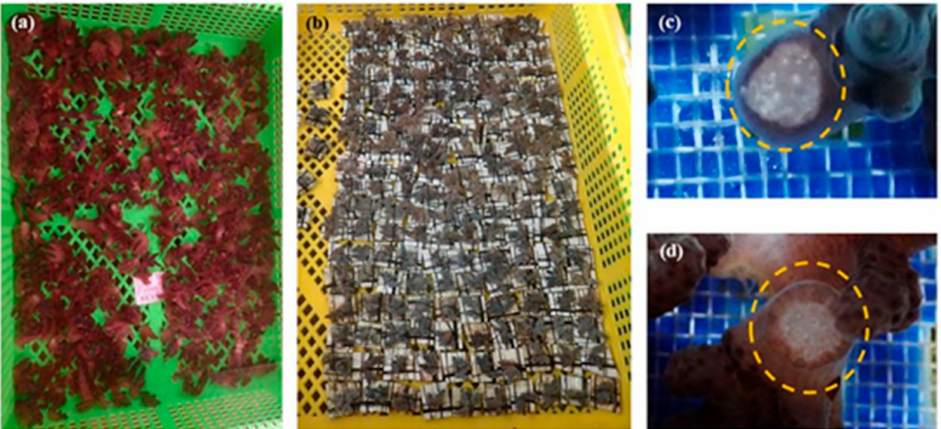
Figure 1. Asexual propagation process of the octocoral S. flexibilis : ( a ) The corals were sliced into small fragments by blade and were left to heal; ( b ) after 10 days, the small coral fragments were attached to tiles with sewing thread; ( c ) the newly cut wounds of the corals; ( d ) two weeks after being cut, the wounds gradually healed. The dotted yellow circles show the